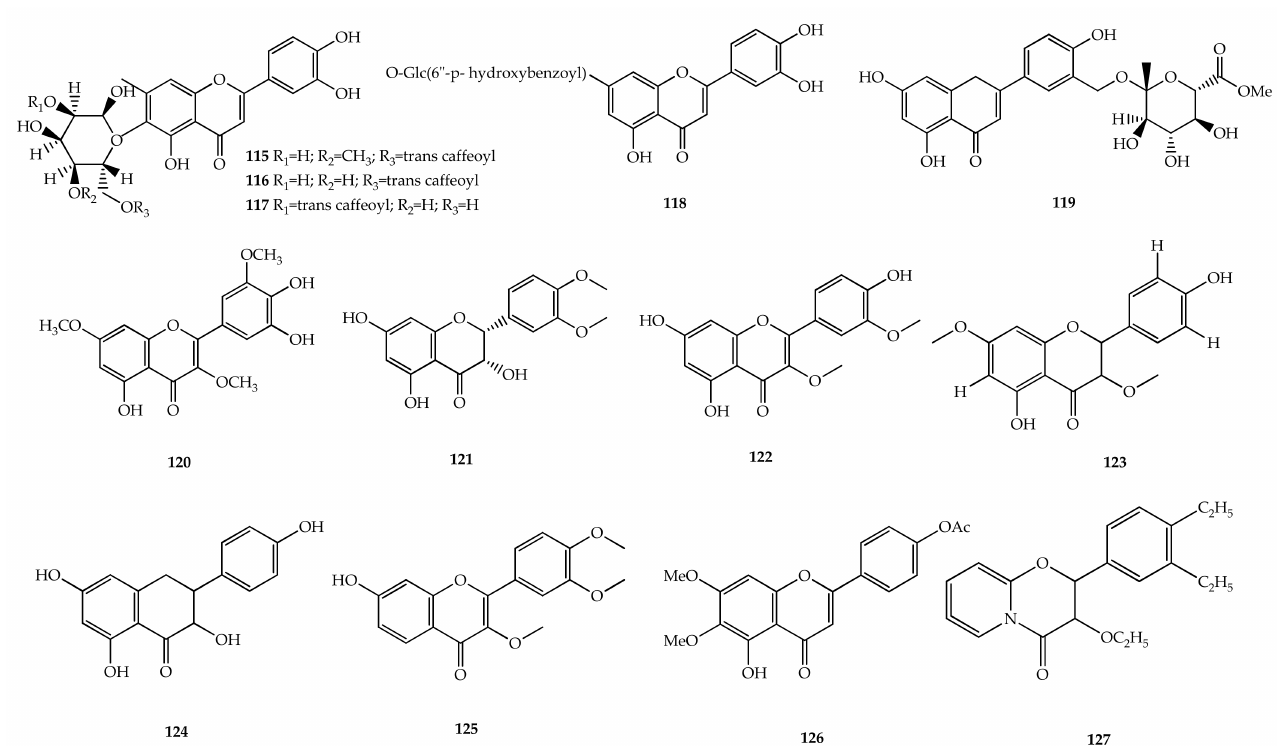
Figure 6. Chemical structures of flavonoids 115 – 127 found in Vitex species.